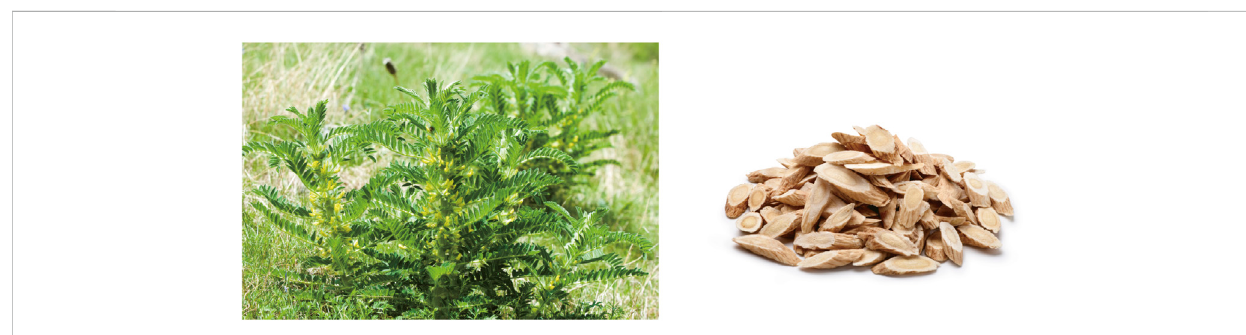
FIGURE 1 Astragali Radix herbs and